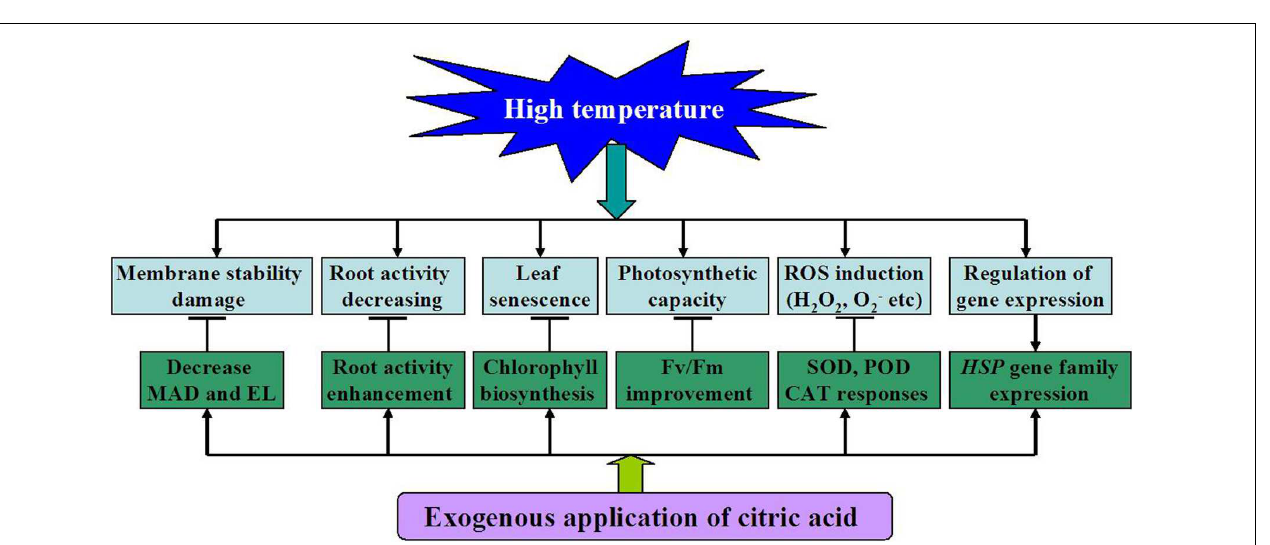
FIGURE 8 | A proposed model for citric acid-mediated high temperature stress responses in tall